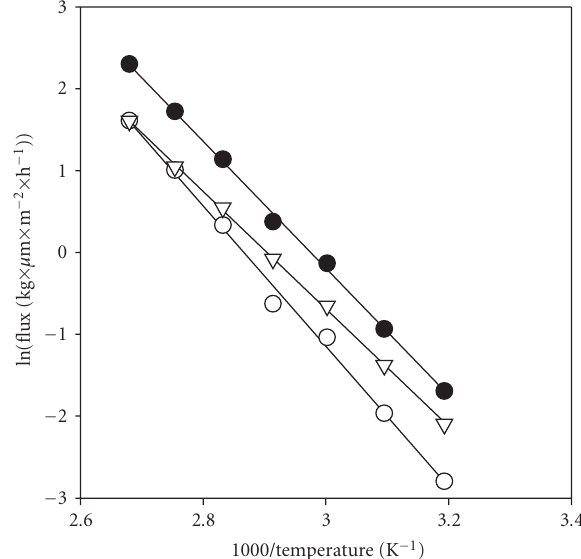
Figure 13: Arrhenius plot (8wt% phenol in feed) with an E-MAA 27 membrane ionically cross-linked with 10% Al 3+ , total flux ( • ), partial water flux ( (cid:2) ), and partial phenol flux ( (cid:4) ).